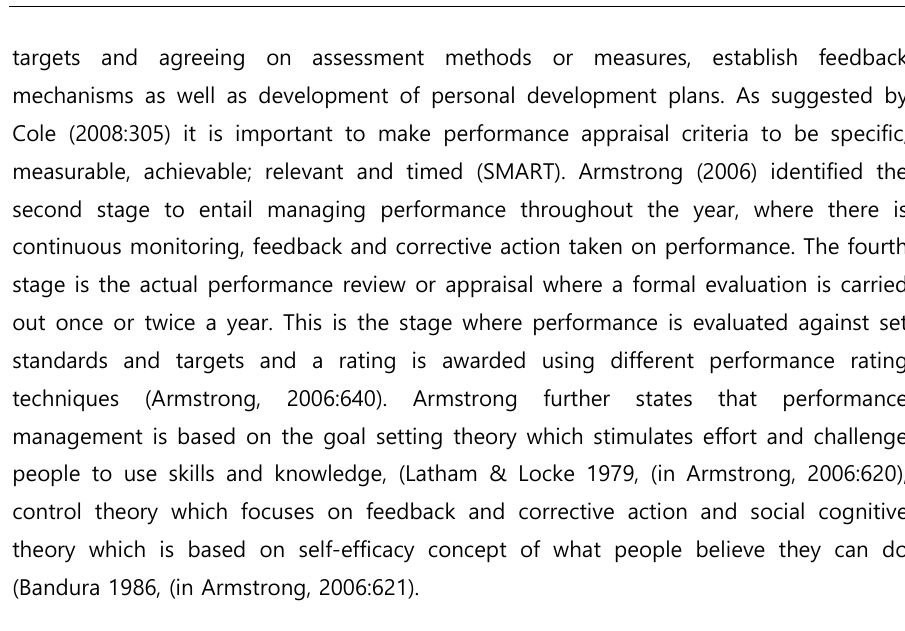
Figure 3: Performance Management Cycle